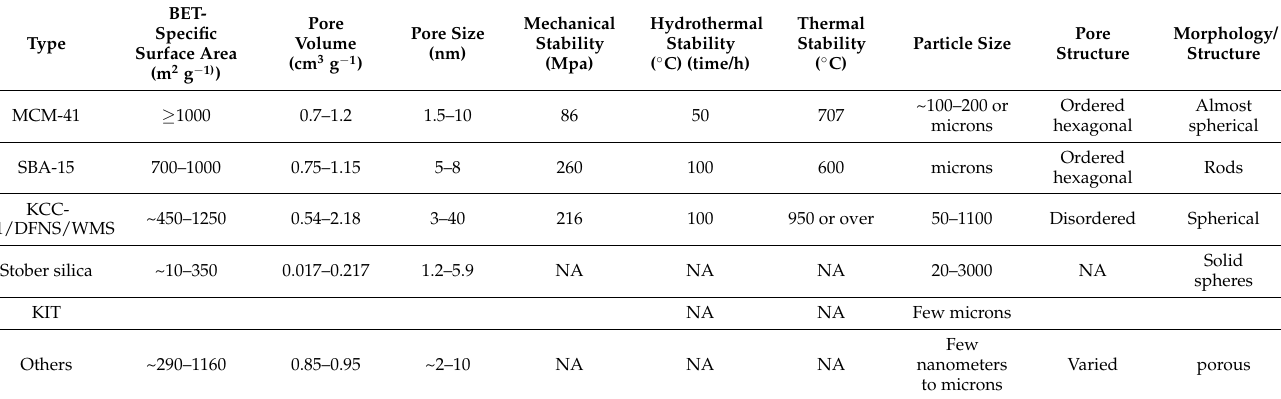
Table 2. The physicochemical properties of the most common mesoporous silica nanoparticles (MSNs) synthesized by various